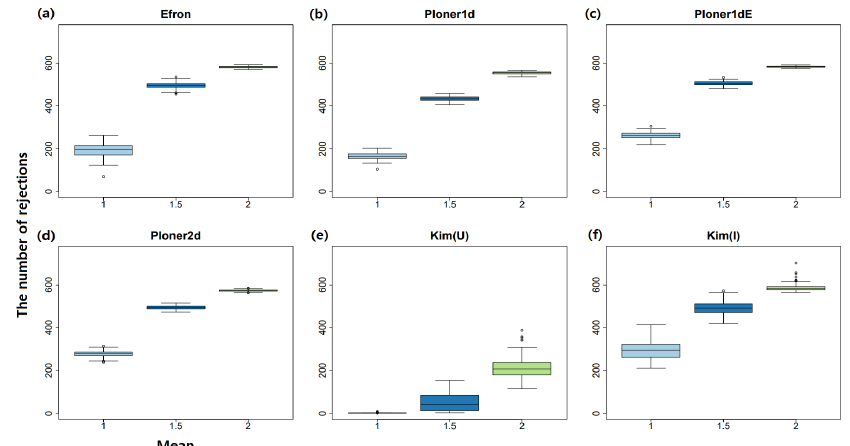
Figure 7. Mean shift scenario and two-sided. The number of rejections by each method over 100 repetitions when cutoff = 0.1. Box plots for three mean values by each method: ( a ) Efron ( b ) Ploner1d